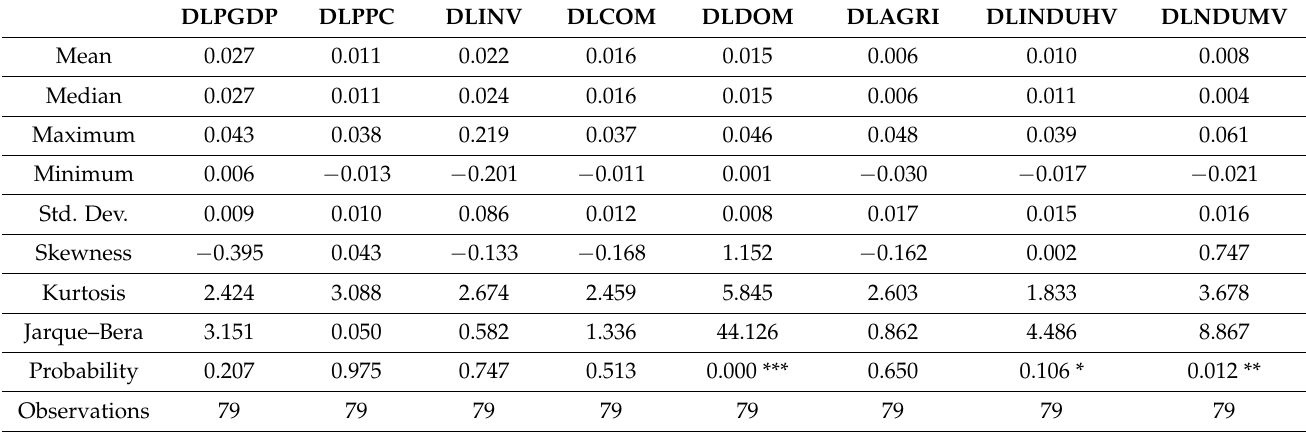
Table 2. Descriptive Statistics of log Difference of the Variables.